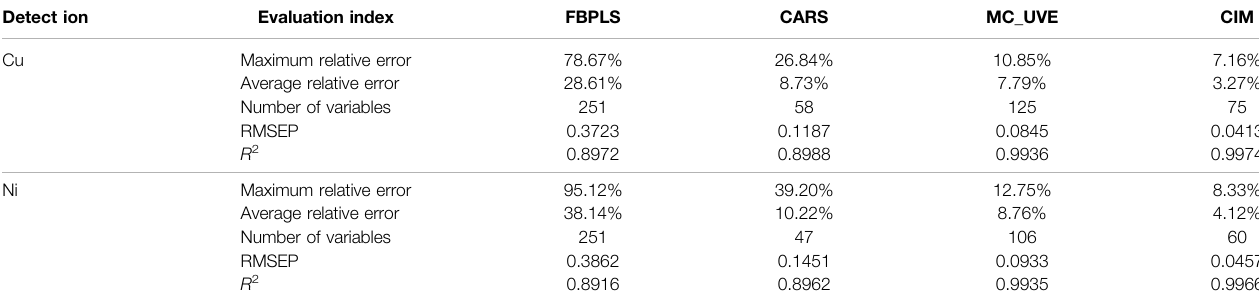
TABLE 3 | The modeling comparison of four feature extraction methods. Detect ion